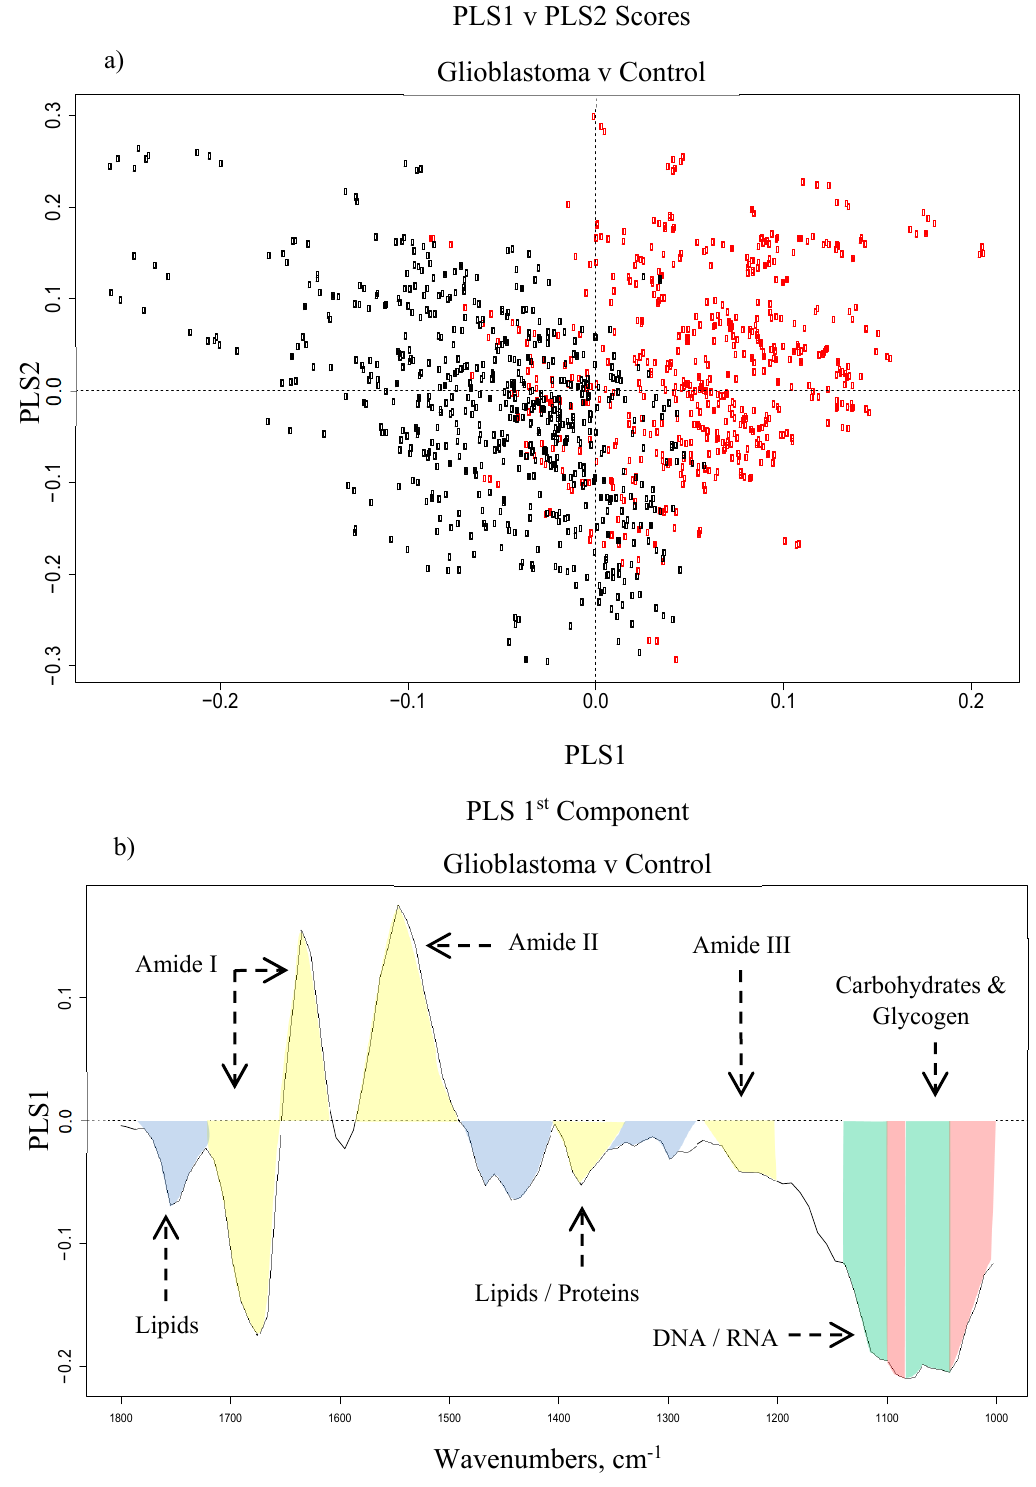
Figure 3. ( a ) Partial least squares (PLS) scores plot between PLS1 and PLS2 for the glioblastoma (black) and control (red) dataset, and ( b ) the loadings for the 1st PLS component with tentative biological assignments: lipids (blue), proteins (yellow), phosphates (green) and carbohydrates (red) .